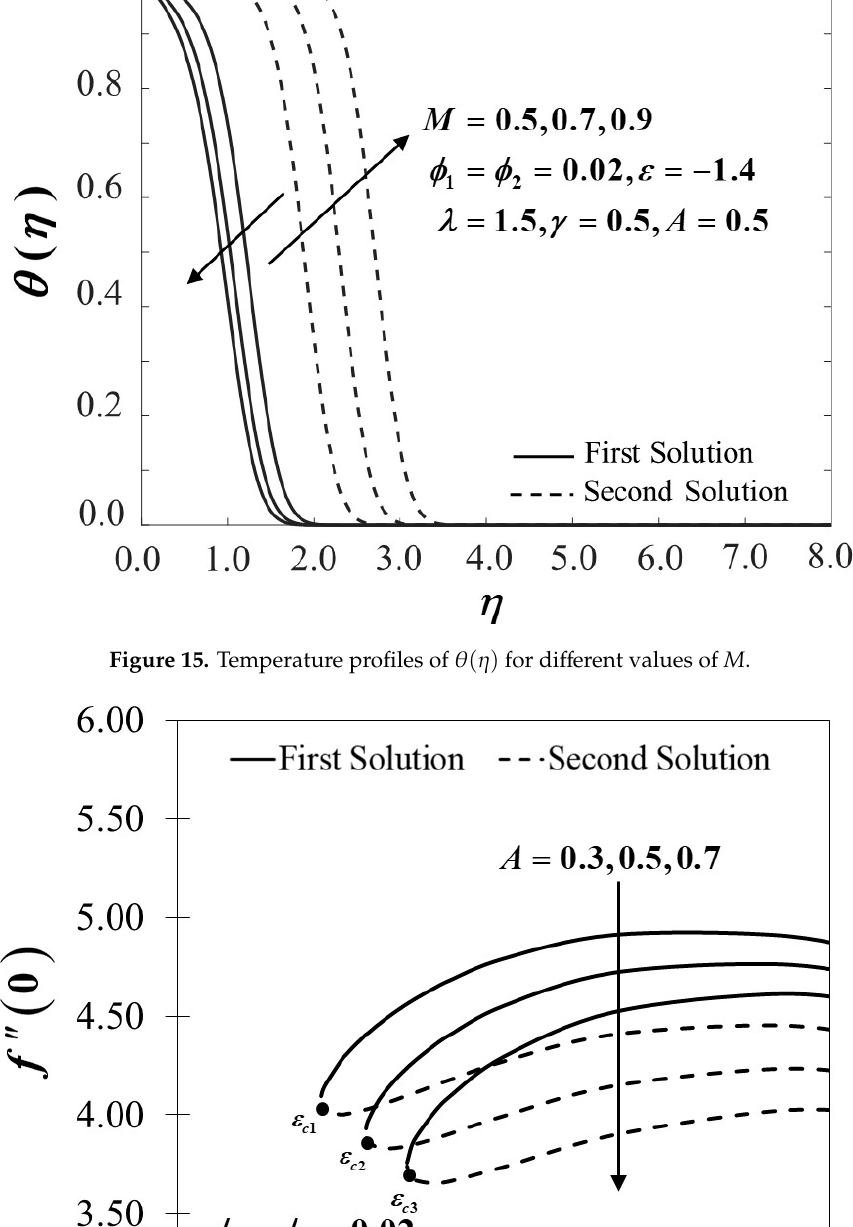
Figure 17. Variations of (0) g ′′ for different values of A .